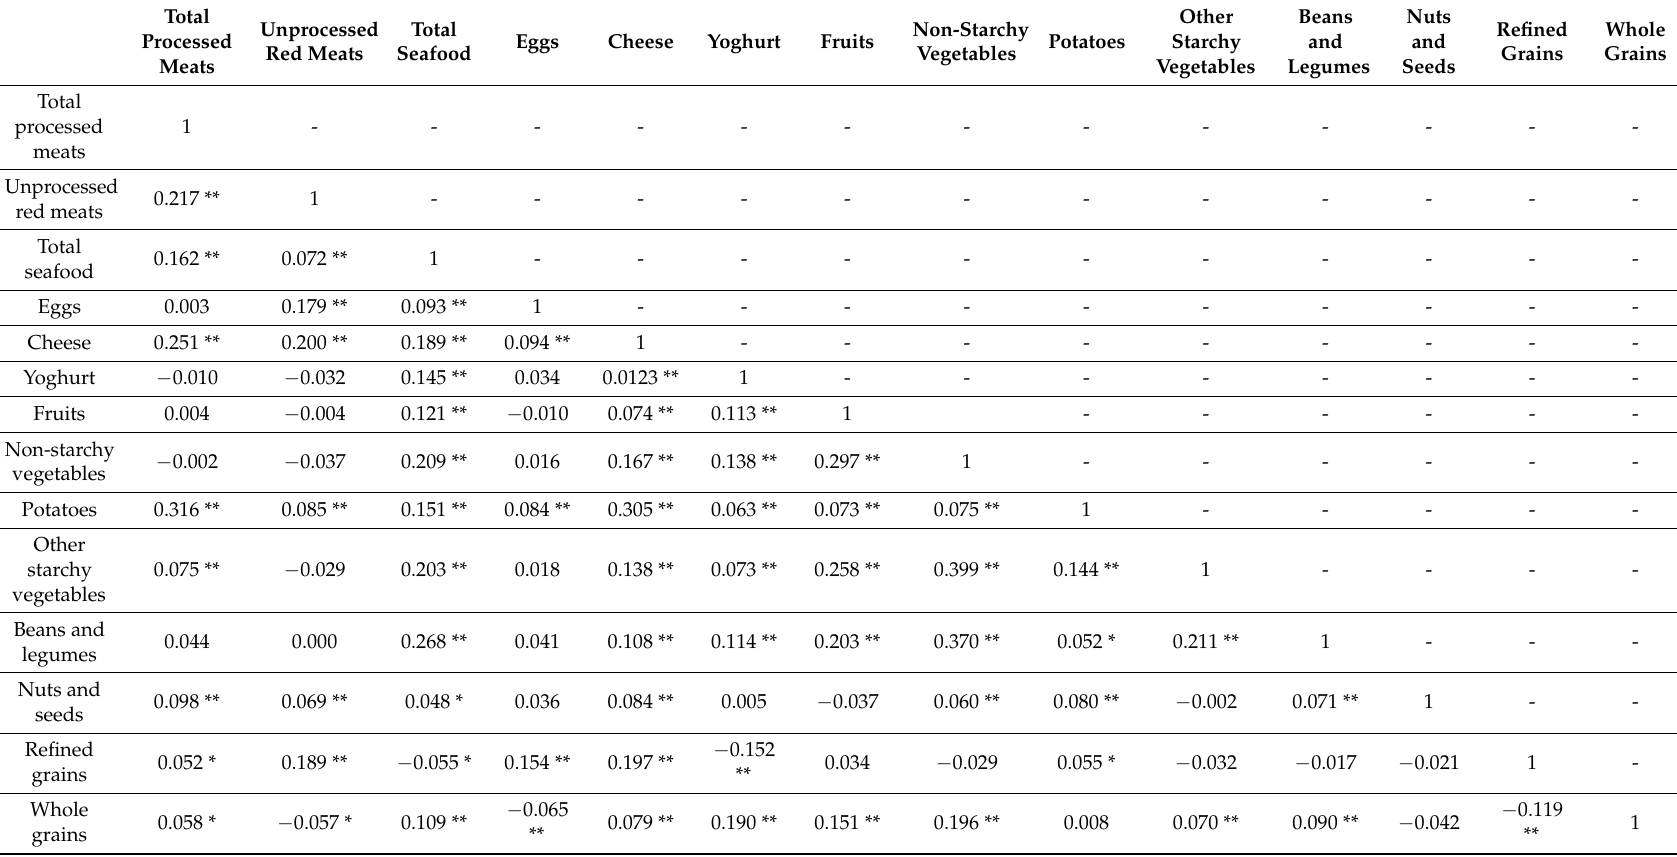
Table 4. Pearson/Spearman correlation coefficients between major food groups intake. * denotes p < 0.05, ** denotes p <